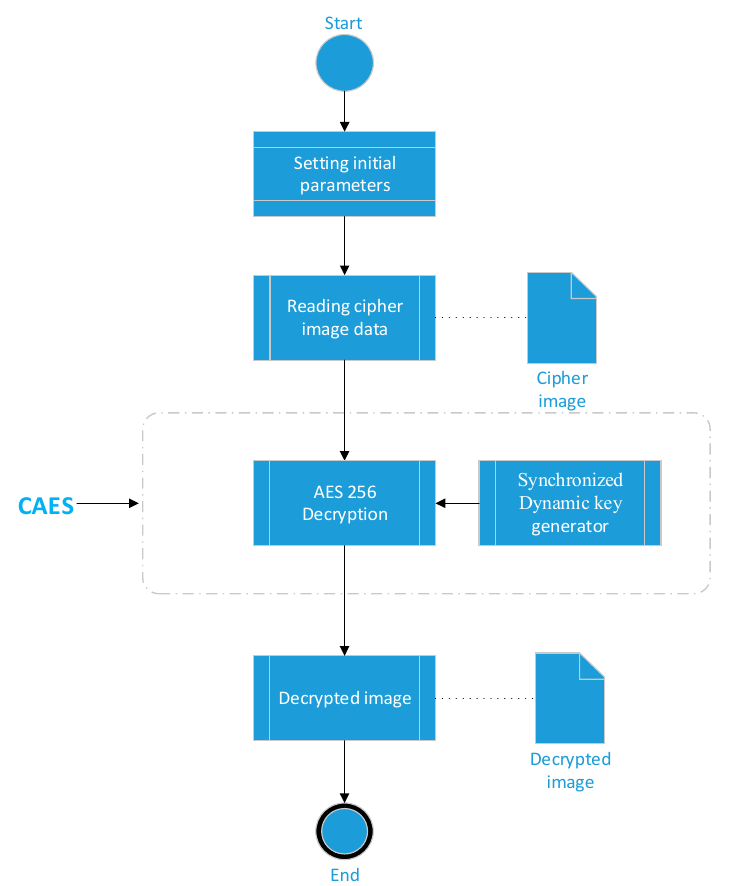
Figure 9. Flow chart of decryption using CAES.